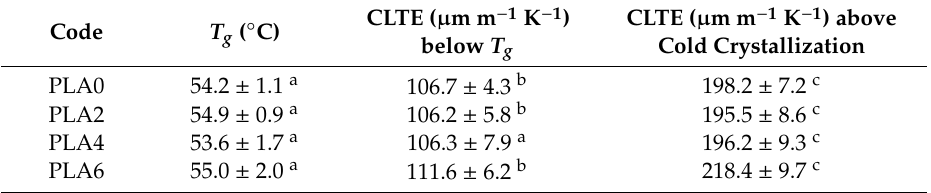
Table 6. Glass transition temperature ( T g ) and coefficients of linear thermal expansion (CLTE) below T g and above cold crystallization temperature ( T cc ) of the injection-molded polylactide (PLA) pieces subjected to different reprocessing cycles.